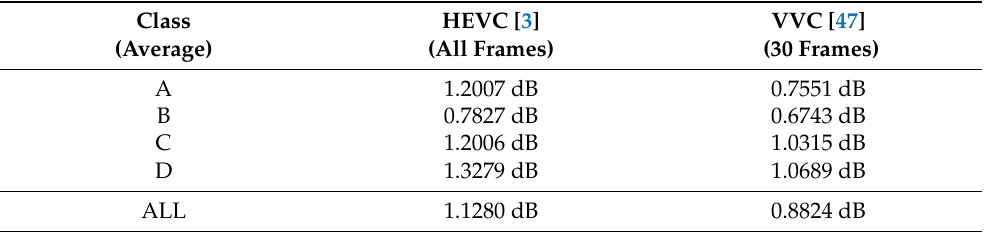
Table 7. Video quality enhancement results computed as Y-BD-PSNR improvement over HEVC- V TSEQ